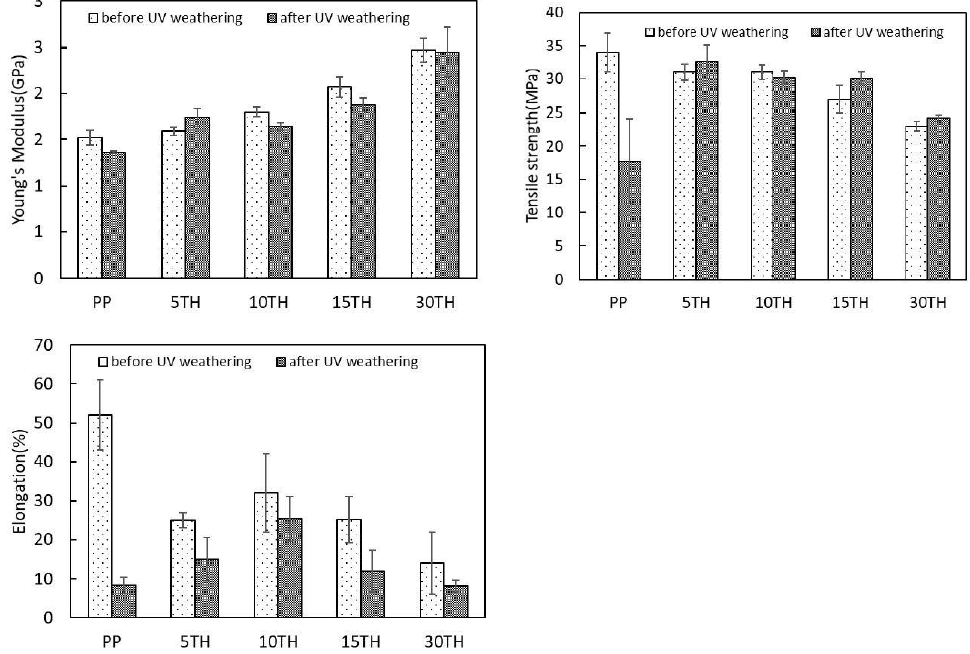
Figure 3. The tensile property of PP and PP/TH composite before and after UV weathering.